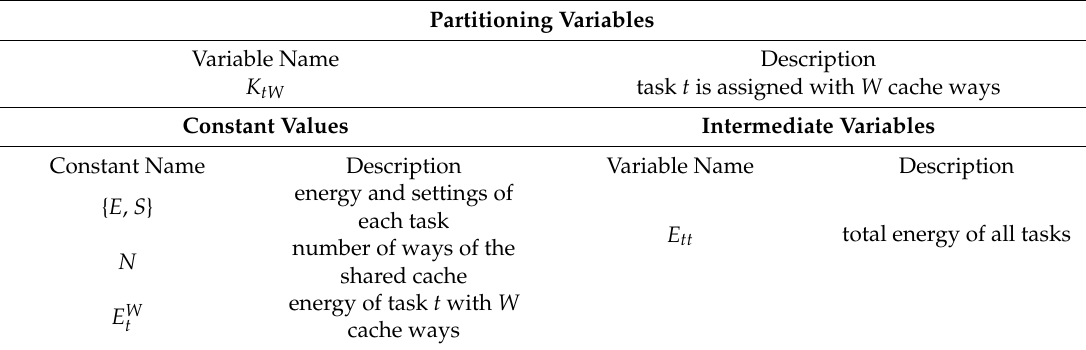
Table 2. Variables and Constants of the MILP Problem for